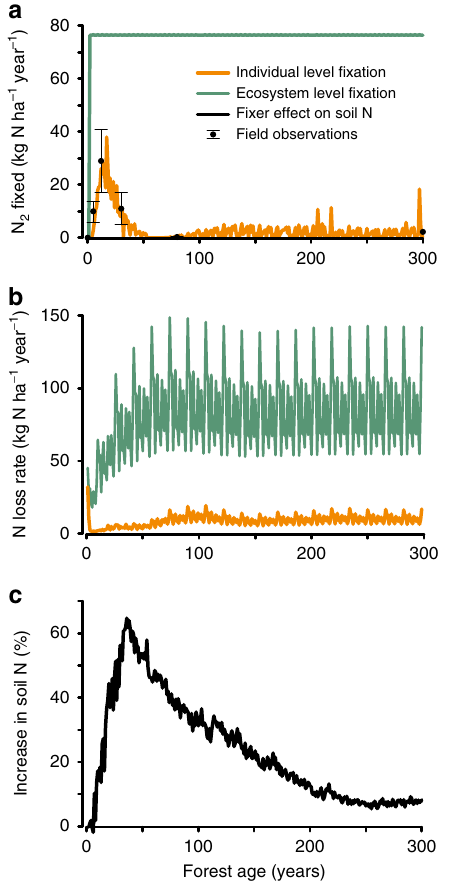
Fig. 1 Successional dynamics in tropical rainforests. a Tree biomass carbon accumulation (above + belowground; MgC ha − 1 ) over successional age (years since disturbance) observed across our Panamanian forests. Black dots indicate fi eld observations 6 of mean biomass carbon ± standard error of the mean (SEM) for n = 4 plots per year for forests 5 – 30 years and n = 2 plots per year for forests 80 – 300 years. Gray line represents Michaelis – Menten curve fi tted to fi eld observations 6 . Orange line represents our model predictions for forests that include all plant functional types and nitrogen fi xation. Red line shows biomass observed in 11 additional mature forests in Panama 6, 38 . b Ecosystem pattern of sum of tree basal area (m 2 ha − 1 ) over forest successional age observed 21 across our Panamanian forests (black points; each point represents one forest plot) and predicted by our model that includes all plant functional types and nitrogen fi xation (orange line). c Tree biomass carbon accumulation (above + belowground; Mg C ha − 1 ) observed across our Panamanian forests (gray line; as described in a ) and predicted by our individual level model for forests with (orange line) and without (blue line) nitrogen fi xation. Also shown are predictions from our ecosystem-level (green line) and nitrogen- saturated (dashed gray line) models. The nitrogen-saturated simulation is initiated with high levels of soil N (20 kg Nm − 2 ) and does not allow dissolved organic nitrogen, dissolved inorganic nitrogen, or nitrogen gas to be lost from the ecosystem. Both the individual level and ecosystem level fi xation simulations are initiated with realistic soil N levels (0.05 kg Nm − 2 ) and allow for nitrogen losses from the ecosystem.